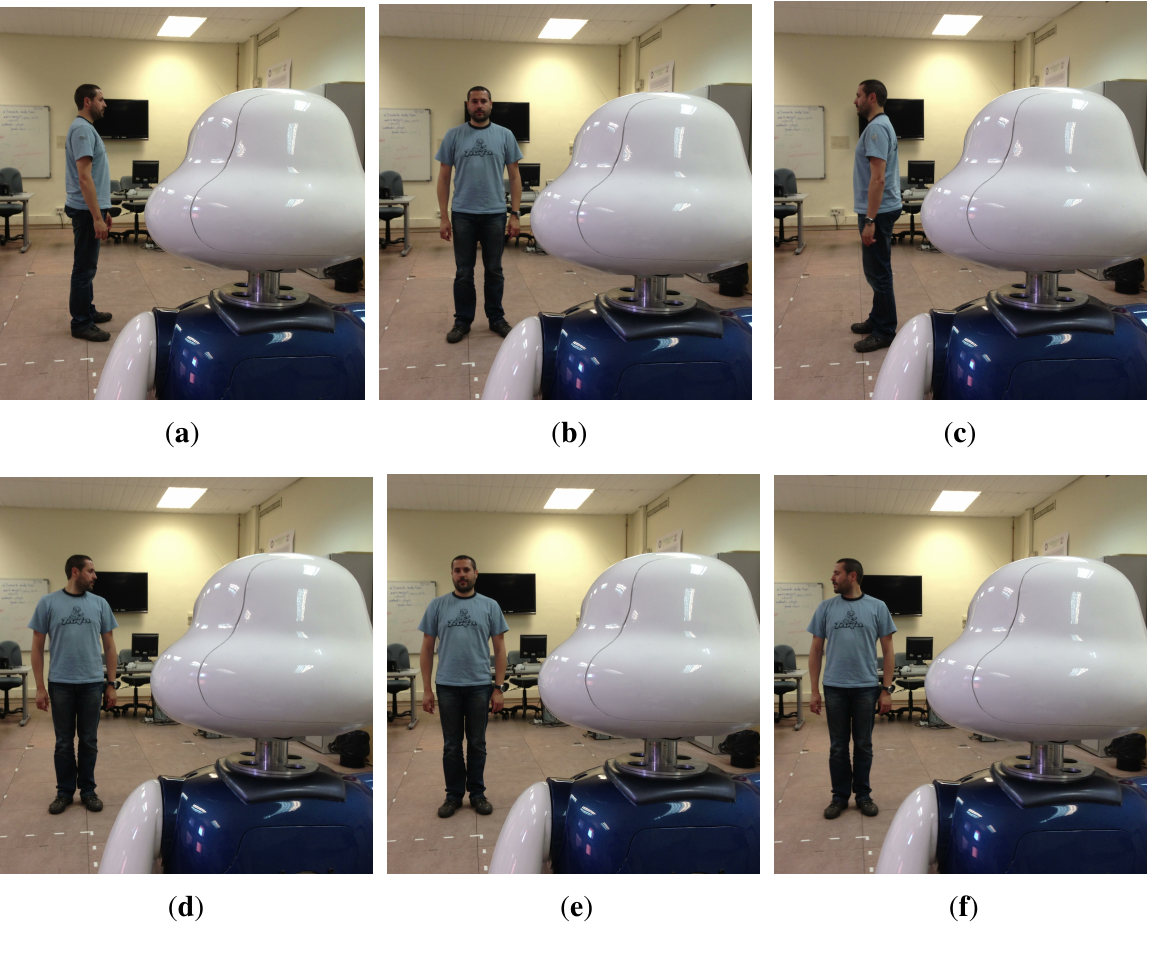
Figure 4. Examples of poses that the users taught to the robot. ( a ) Turned Left; ( b ) turned forward; ( c ) turned right; ( d ) looking left; ( e ) looking forward; ( f ) looking right; ( g ) pointing left; ( h ) pointing forward; ( i ) pointing